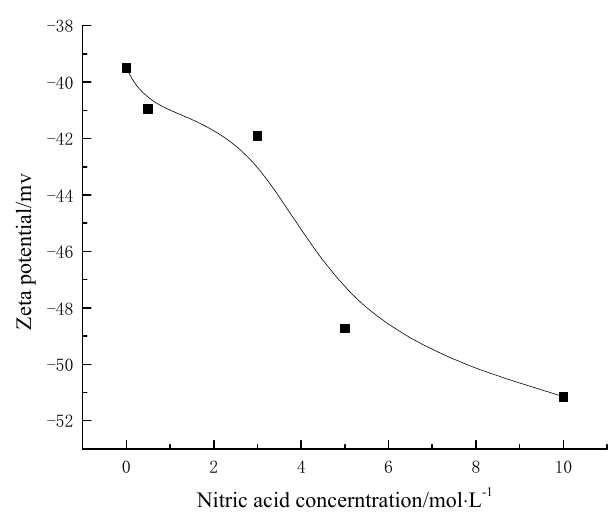
Figure 11. Zeta potential of lignite and nitric acid-modified lignite.